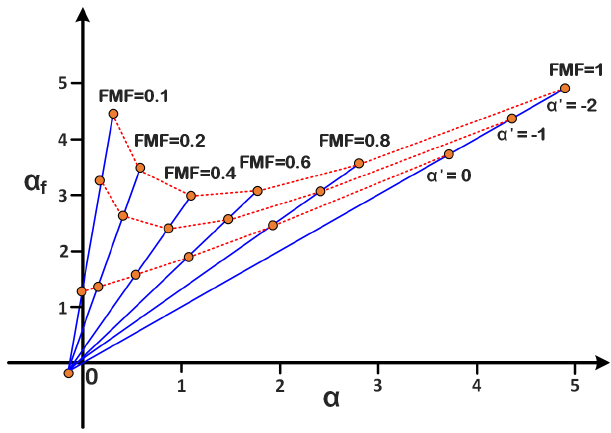
Figure 2. Visual representation of SDA-based FMF retrieval